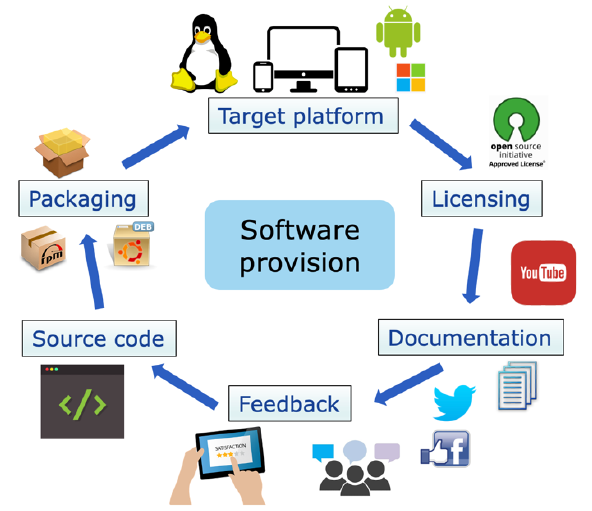
Figure 1 . Typical aspects of software